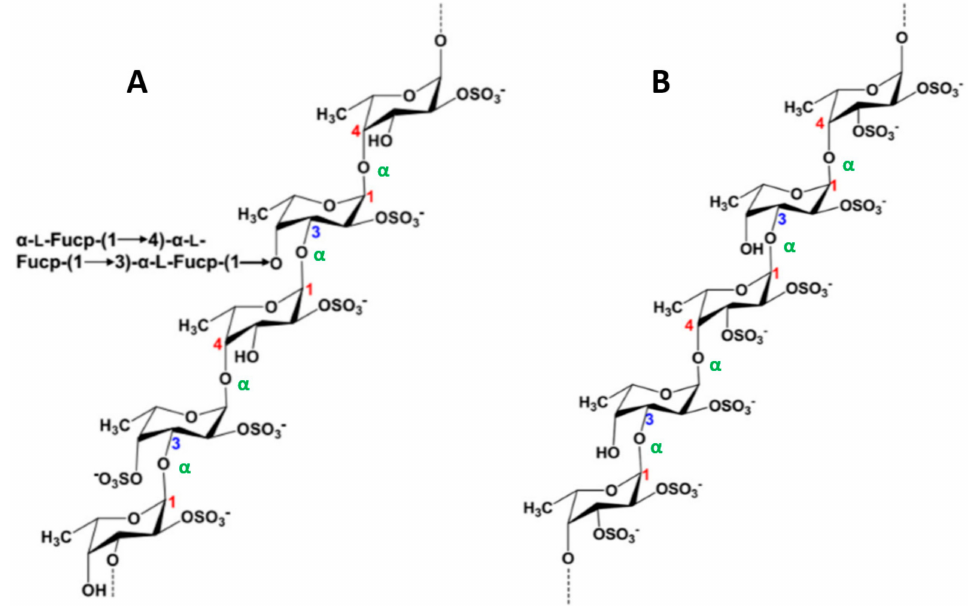
Figure 4. Structures of fucoidans extracted from brown seaweeds of the Fucales order. ( A ) Fucoidan of Fucus serratus (and Ascophyllum nodosum ) composed of a main chain of (1 → 3)- and (1 → 4)- α - l -Fuc p with short branches of α - l -Fuc p -(1 → 4)- α - l -Fuc p and α - l -Fuc p -(1 → 3)- α - l -Fuc p in O -4 of α -(1 → 3)- l -Fuc p and sulfate groups in O -2 and / or O -4 positions. ( B ) Fucoidan extracted from Fucus evanescens consisting of a main skeleton of (1 → 3)- and (1 → 4)- α - l -Fuc p highly substituted by sulfate groups at O -2 and / or O -3